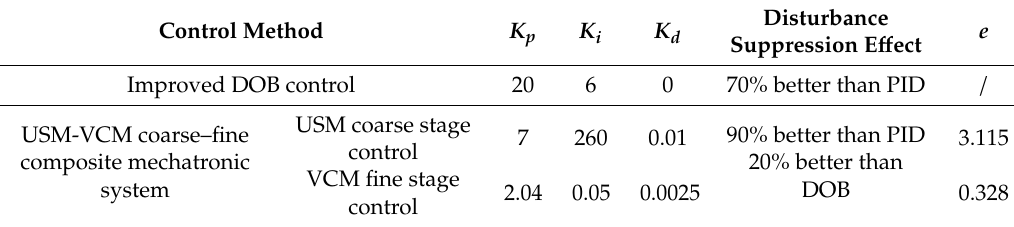
Table 1. Parameters and performance of the coarse–fine composite mechatronic